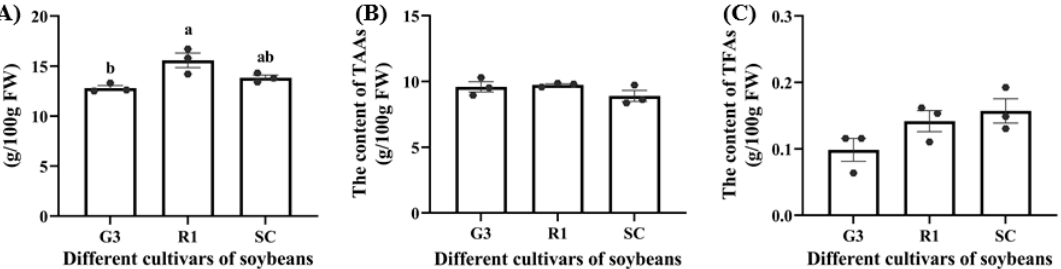
Figure 5. The content of crude protein (CP) ( A ), total amino acids (TAAs) ( B ) and total fatty acids (TFAs) ( C ) in C. bilineata tsingtauica larvae fed on different soybean cultivars. Data are means ± SEM. The lowercase letters in the figure indicate significant difference among different cultivars ( p < 0.05, Tukey test). FW: fresh weight.